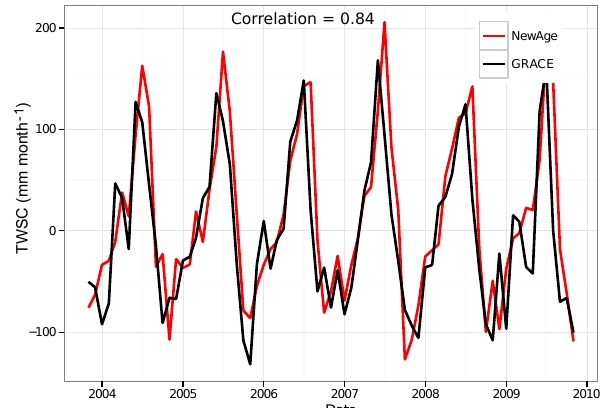
Figure 6. Comparison between basin-scale (whole UBN, 176315 square kilometers) NewAge d s / d t and GRACE TWSC from 2004 to 2009 at monthly time